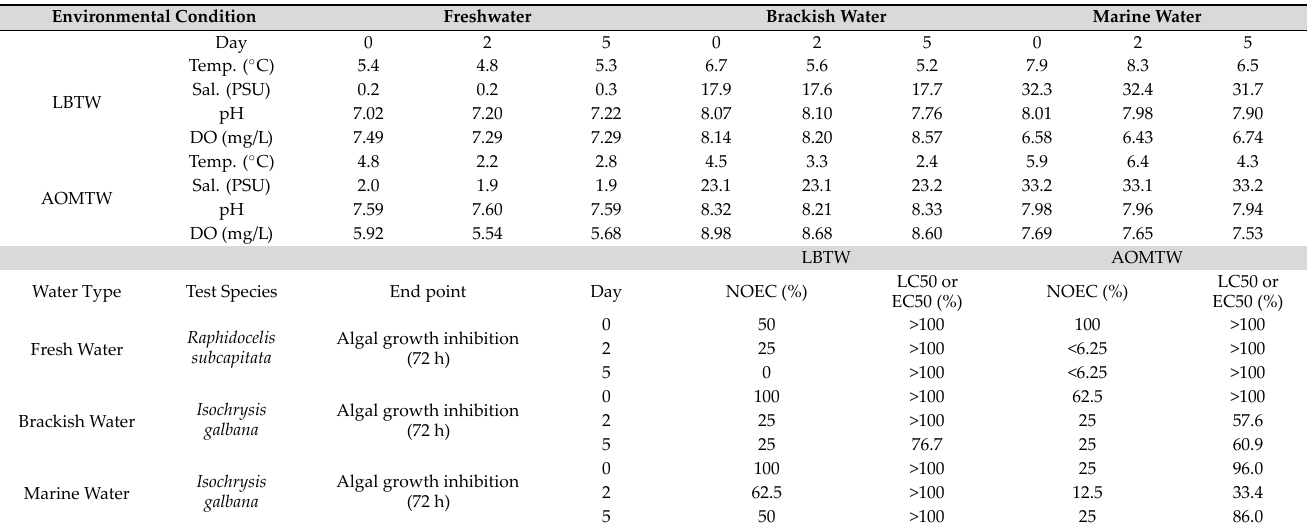
Table 6. Water quality parameters for the samples used for WET tests and subsequent results on Days 0, 2, and 5 using microalgae exposed for 72 h to treat the land‑based test water (LBTW) and algal organic matter test water